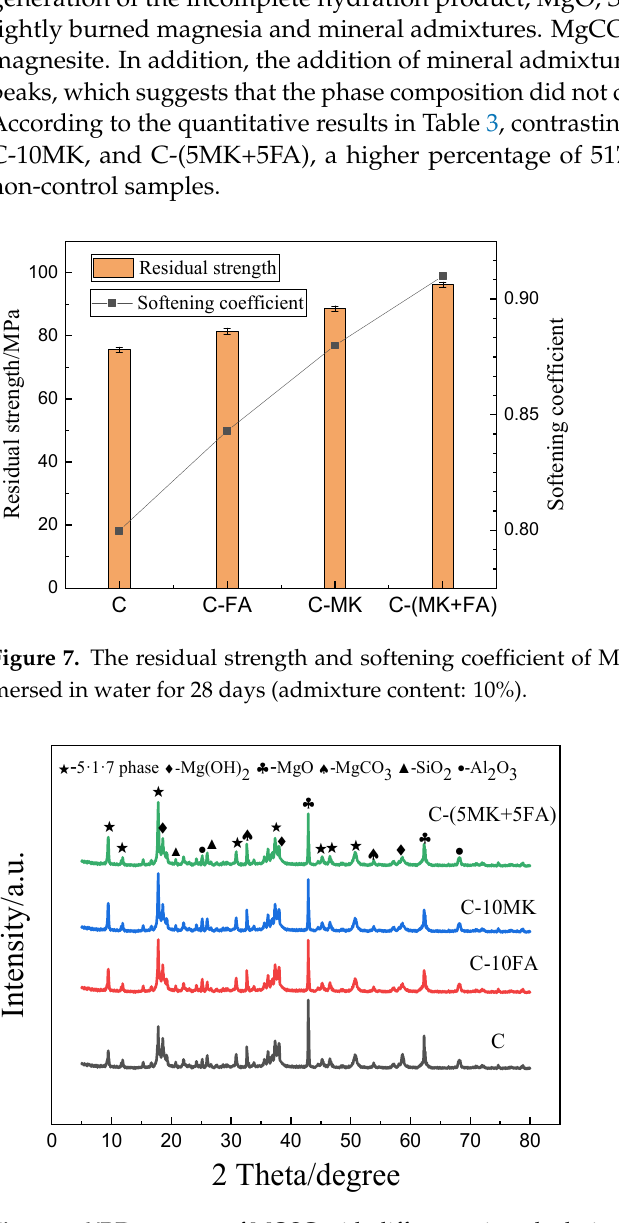
Figure 8. XRD patterns of MOSC with different mineral admixtures after 28 days of curing. Table 3. Phase composition of the MOSC after 28 days of curing analyzed using Topas4.2 (%). Samples